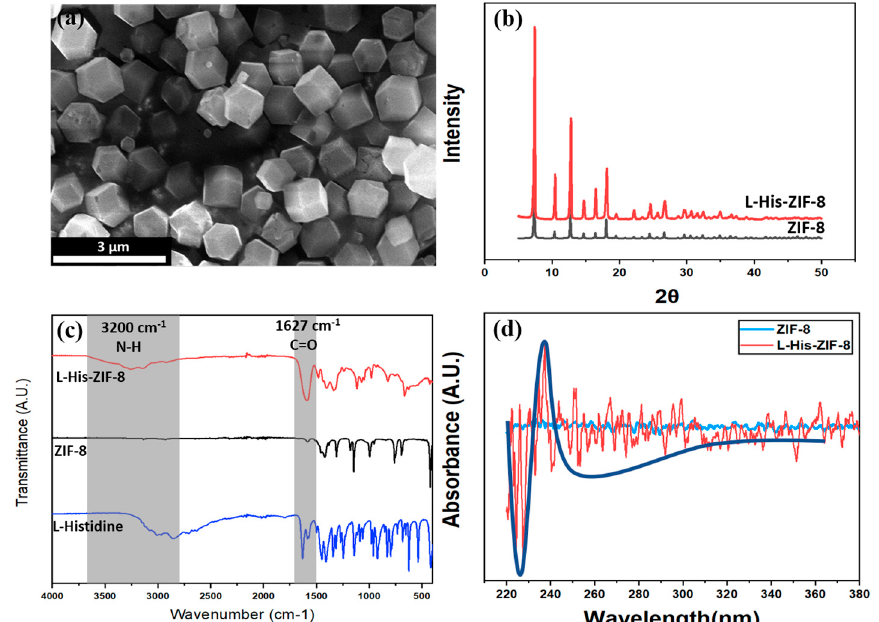
Figure 3. Characterization of the Synthesized L-His-ZIF-8: ( a ) SEM Images of the synthesized L-His- ZIF-8. ( b ) PXRD patterns of ZIF-8 and L/D-His-ZIF-8. ( c ) FTIR Spectra of L-His-ZIF-8, ZIF-8, and L-histidine, respectively. ( d ) Circular Dichroism spectra of ZIF-8 and L-His-ZIF-8.